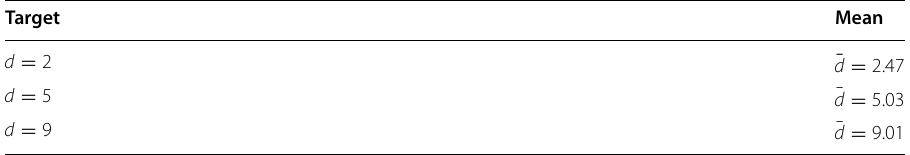
Target degree and observed mean degree from simulation